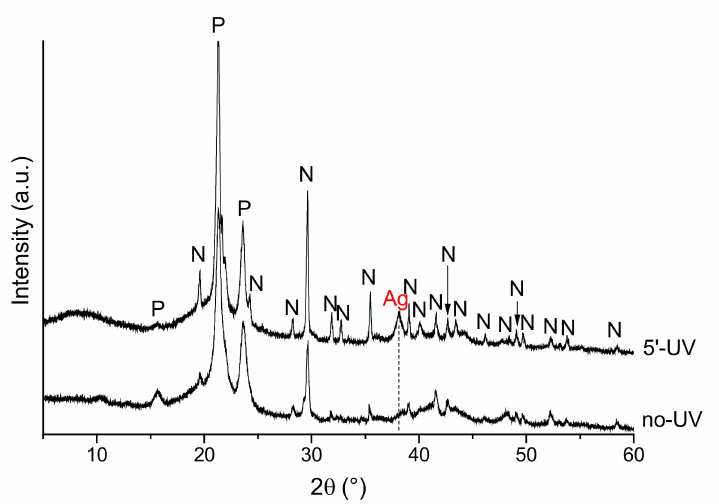
Figure 12. XRD patterns of silver nitrate (AgNO 3 )-PCL samples before and after ultraviolet (UV) irradiation (P = PCL; N = AgNO 3 ; Ag = metal